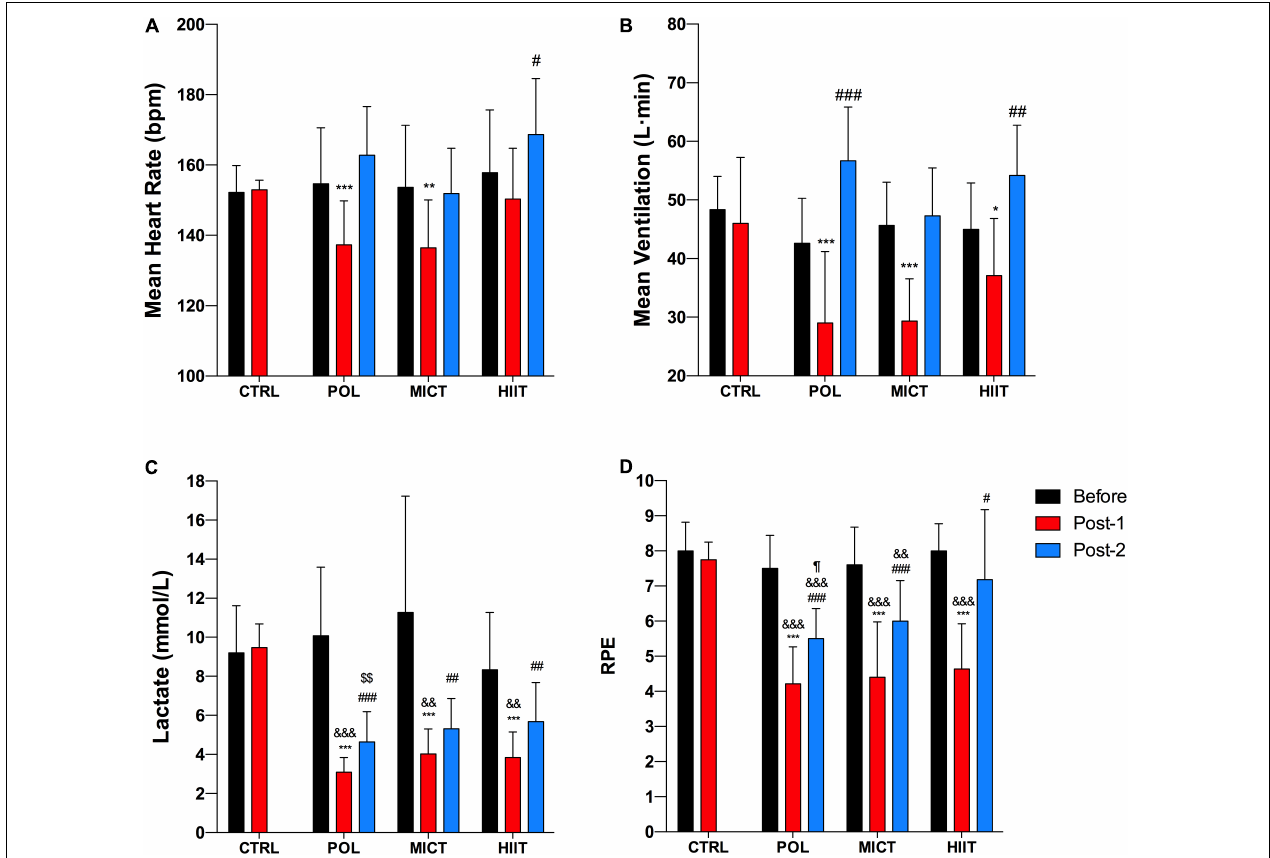
FIGURE 6 | Effects of training intervention on cardiorespiratory response, blood lactate, and rating of perceived exertion during a cycling trial at 60% of pVO 2 peak. (A) Mean heart rate, (B) mean ventilation, (C) blood lactate, and (D) RPE after 12-weeks of control (CTRL), polarized volume training (POL), moderate-intensity endurance training (MICT), and high-intensity interval training (HIIT). Data are shown as mean ± SD. ∗ , ∗∗ , and ∗∗∗ denote differences between Pre and Post-1 values (time effect: p < 0.05, p < 0.01, and p < 0.001, respectively). # , ## , and ### denote differences between Pre and Post-2 values (time effect: p < 0.05, p < 0.01, and p < 0.001, respectively). && and &&& denote differences in Post-1 values vs. CTRL group after intervention ( p < 0.01 and p < 0.001, respectively). $$ Denote differences in Post-2 values vs. CTRL group after intervention ( p < 0.01). ¶ Denote differences in Post-2 values between Pol and HIIT group after intervention ( p < 0.05). The comparison was performed with Mixed Factorial ANOVAs with Bonferroni’s post hoc test for multiple comparisons. Post-1 and Post-2: after training at 60% of pre-pVO 2 peak value and 60% of post-pVO 2 peak value, respectively. RPE, rating of perceived